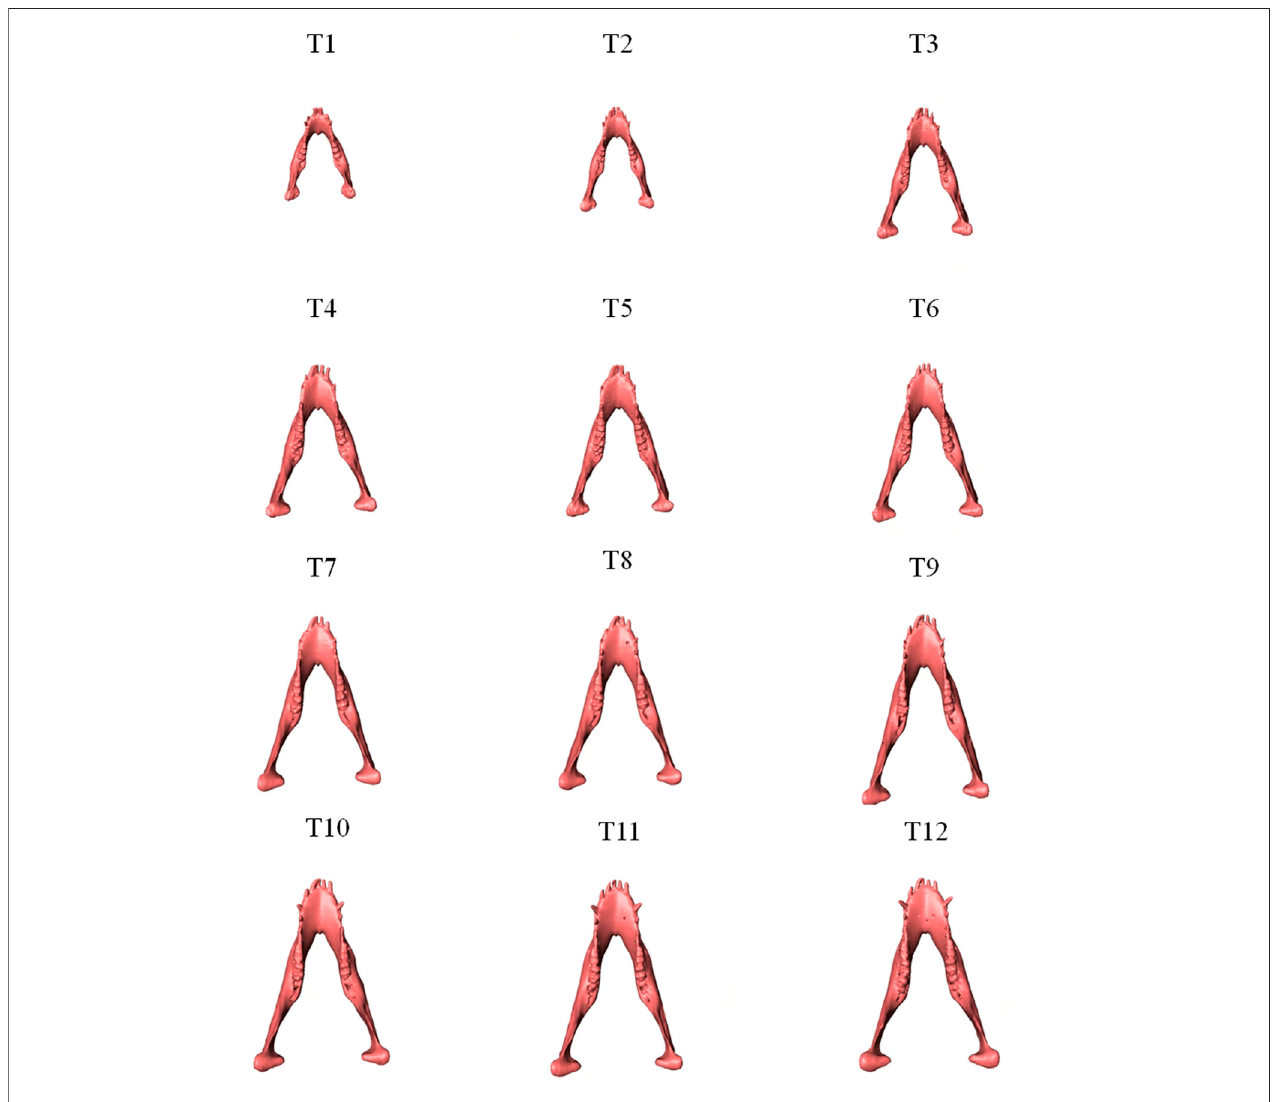
FIGURE 3 | Superior view of the mandibles of a typical subject showing monthly size and shape changes over the growing period from T1 to T12.